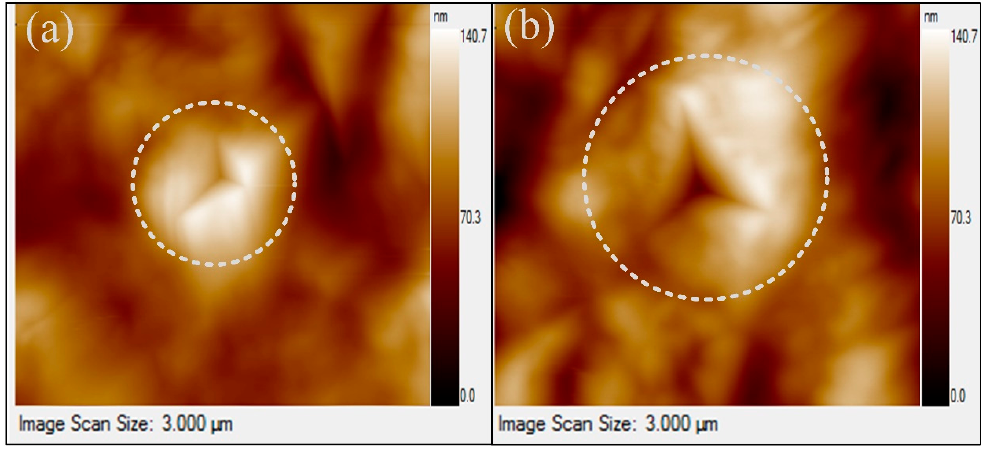
Figure 4. Indenter impression over the ( a ) parent glass material and ( b ) glass machined through ECSM process.